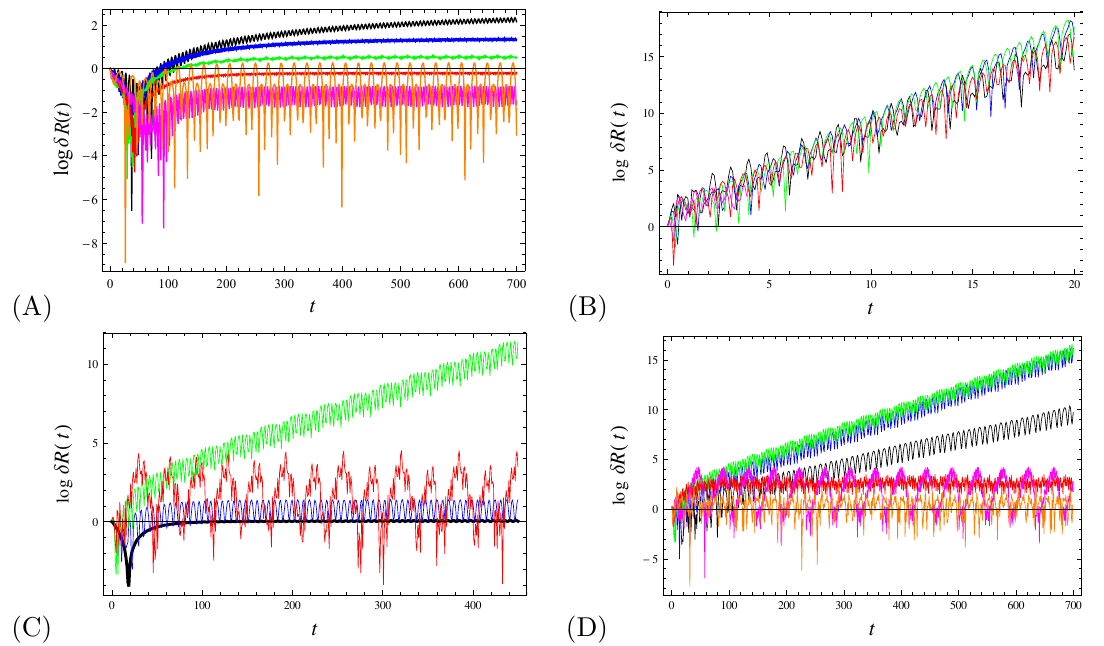
Figure 5 . (A) Logarithm of the radial variation (cid:14)R for near-horizon orbits with n = 1 ; 2 ; 3 ; 4 ; 5 ; 6 (black, blue, green, red, magenta, orange) in a planar extremal Reissner-Nordstrom geometry. All curved asymptote to a constant, i.e., (almost) zero slope, resulting in (cid:21) (cid:25) 0. (B) Same as previ- ous for an extremal hyperbolic black hole. Now the Lyapunov exponent is nonzero, and equal for all winding numbers: in absence of thermal scrambling, the chaos originates solely from scatter- ing, which is independent of n . (C) The Lyapunov exponent in zero-temperature hyperbolic black hole background for n = 1 and r = r h ; 1 : 1 r h ; 1 : 2 r h ; 1 : 3 r h (black, blue, green, red) starts at zero (no scrambling, no scattering), grows to a clear nonzero value for larger radii due to scattering, and again falls to zero for still larger distances, as the geometry approaches pure AdS (D) Lyapunov exponent in T = 0 : 02 hyperbolic black hole background for n = 1 and r = r h ; 1 : 1 r h ; 1 : 2 r h ; 1 : 3 r h ; 1 : 4 rh; 1 : 5 r h (black, blue, green, red, magenta, orange) starts at the scrambling value (black), reaches its max- imum when both scrambling and scattering are present (blue, green) and then falls to zero when AdS is approached (red, magenta,